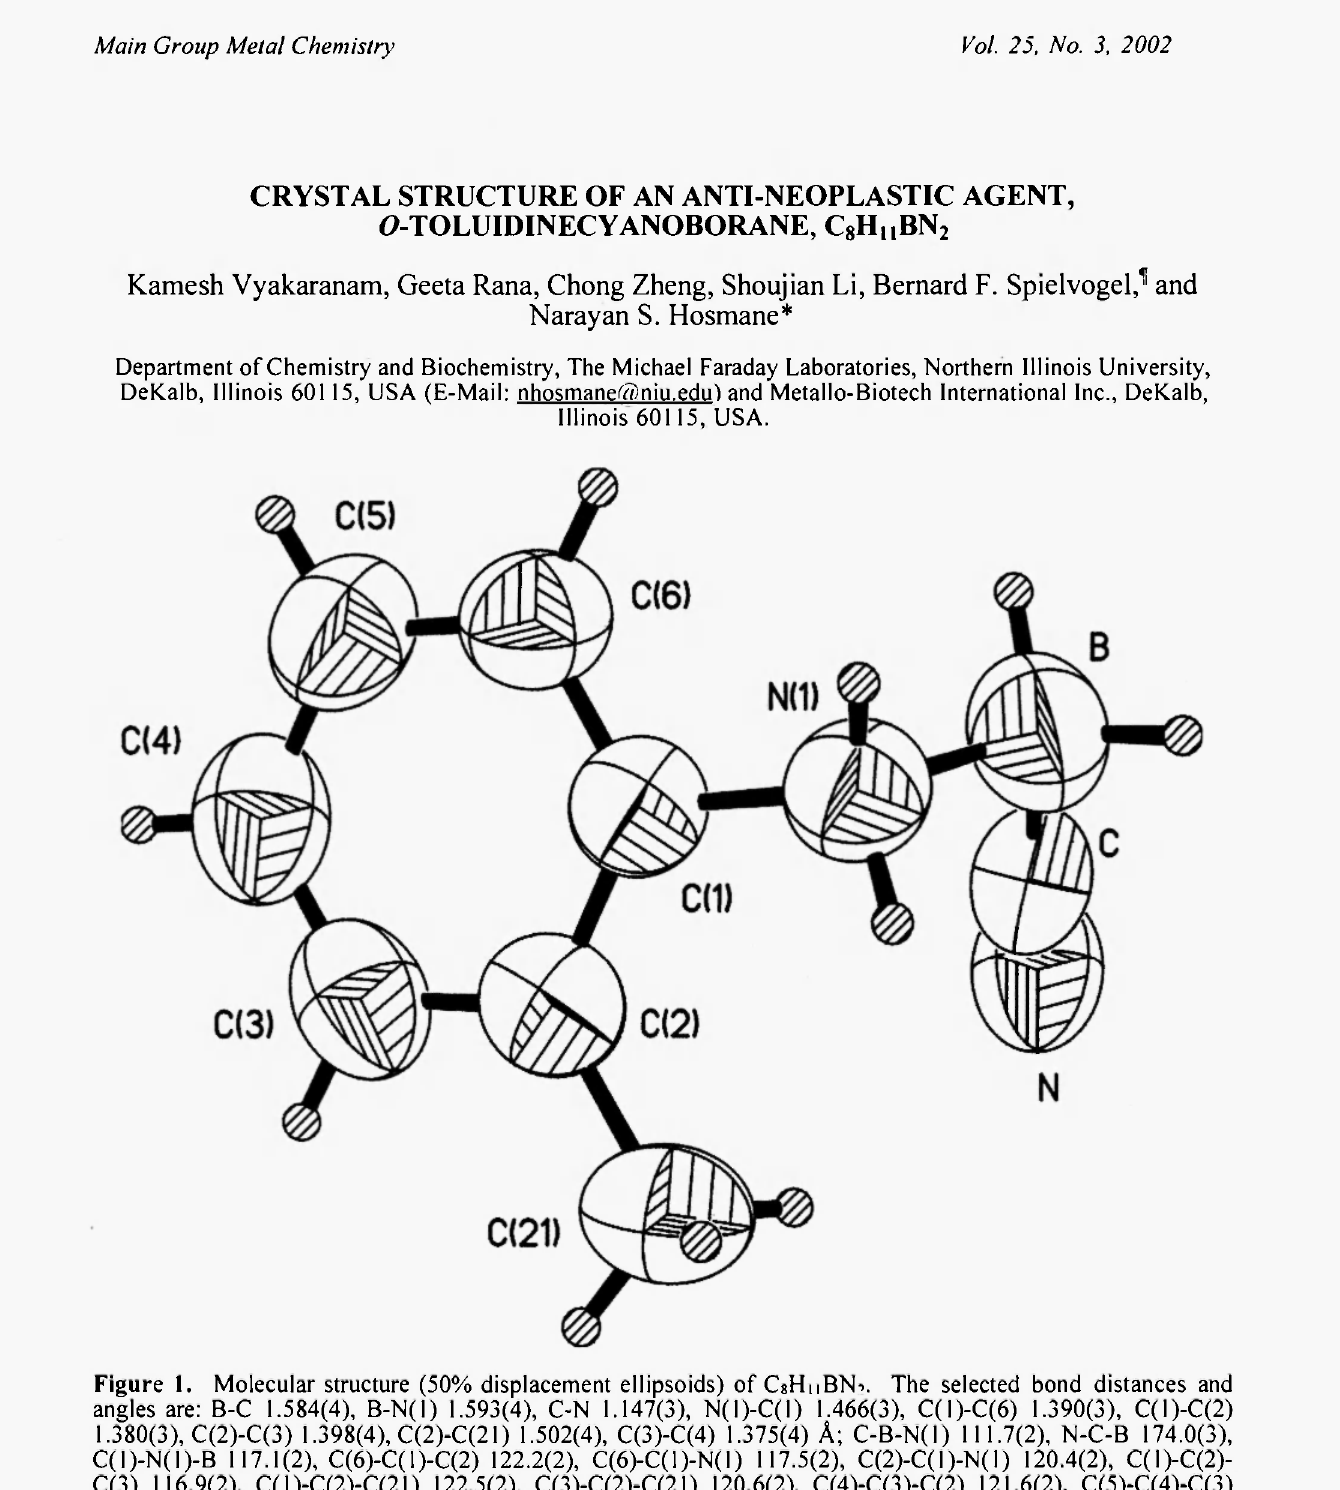
Figure 1. Molecular structure (50% displacement ellipsoids) of CSHMBNI. The selected bond distances and angles are: B-C 1.584(4), B-N(l) 1.593(4), C-N 1.147(3), N(l)-C(l) 1.466(3), C(l)-C(6) 1.390(3), C(l)-C(2) 1.380(3), C(2)-C(3) 1.398(4), C(2)-C(21) 1.502(4), C(3)-C(4) 1.375(4) A; C-B-N(l) 111.7(2), N-C-B 174.0(3), C(l)-N(l)-B 117.1(2), C(6)-C(l)-C(2) 122.2(2), C(6)-C(l)-N(l) 117.5(2), C(2)-C(l)-N(l) 120.4(2), C(l)-C(2)- C(3) 116.9(2), C(l)-C(2)-C(21) 122.5(2), C(3)-C(2)-C(21) 120.6(2), C(4)-C(3)-C(2) 121.6(2), C(5)-C(4)-C(3)